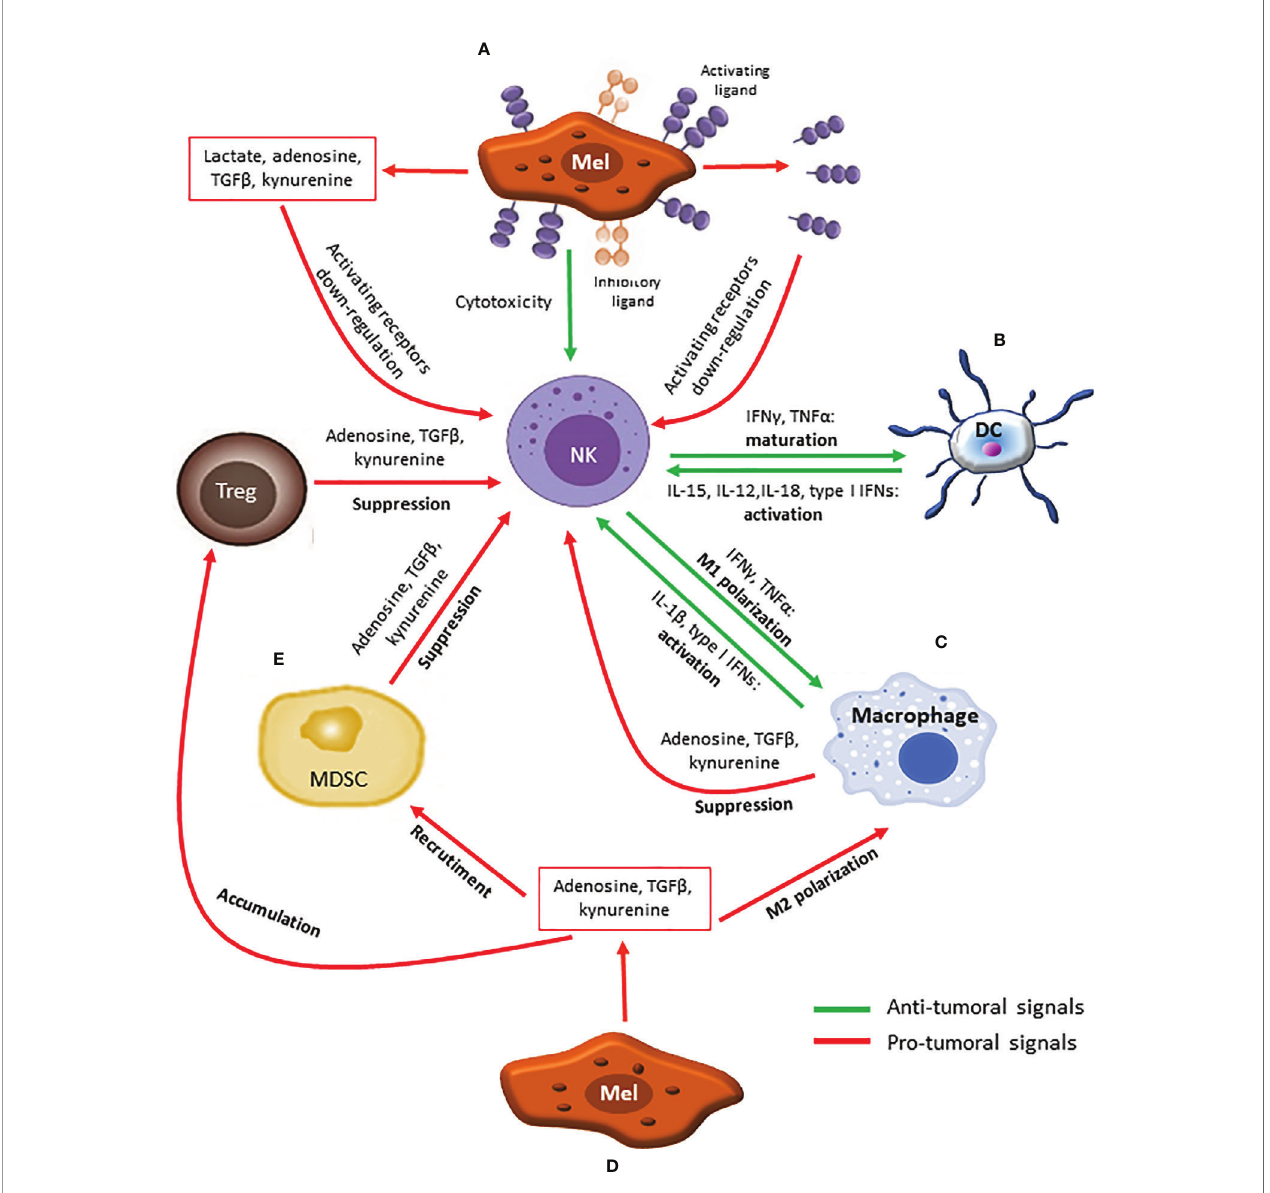
FIGURE 2 | The complex cross-talk affecting the activity of NK cells within melanoma TME. (A) Melanoma cells phenotype, characterized by low levels of MHC class I molecules and high levels of activating ligands, promotes NK cells activation and killing. Additionally, melanoma cells can exploit both intrinsic (down-regulation/ shedding of activating ligands) and extrinsic (secretion of immune suppressive molecules) mechanisms to escape from NK cell-mediated elimination. (B) Dendritic Cells (DCs) secrete cytokines such as IL-15, IL-12, IL-18 and type I IFNs which induce NK cells activation. In turn, activated NK cells produce IFN g and TNF a , promoting DCs maturation. (C) Similar to DCs, M1 macrophages promote NK cells activation through the release IL-1 b and type I IFNs, while IFN g and TNF a secreted by activated NK cells further support M1 polarization. (D) Aside from direct effects against NK cells, immune suppressive molecules secreted by melanoma cells also induce M2 polarization, MDSCs recruitment and Tregs accumulation. (E) In turn, MDSCs and Tregs exploit suppressive molecules (Adenosine, TGF b , kynurenine) to counteract NK cells